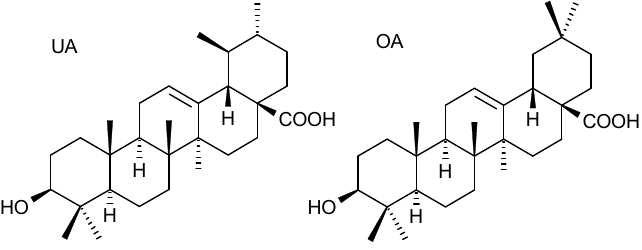
Figure 1. Molecular structures of ursolic acid (UA) and oleanolic acid (OA).